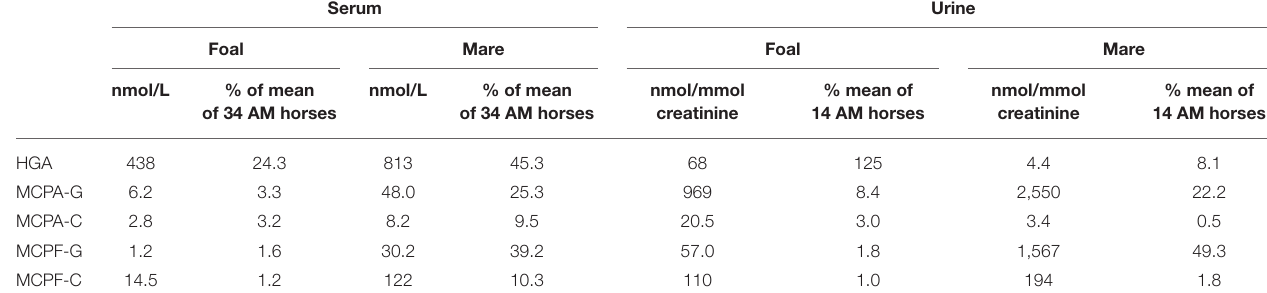
TABLE 1 | Hypoglycin A and toxin metabolites in serum and urine of the foal and his mare.